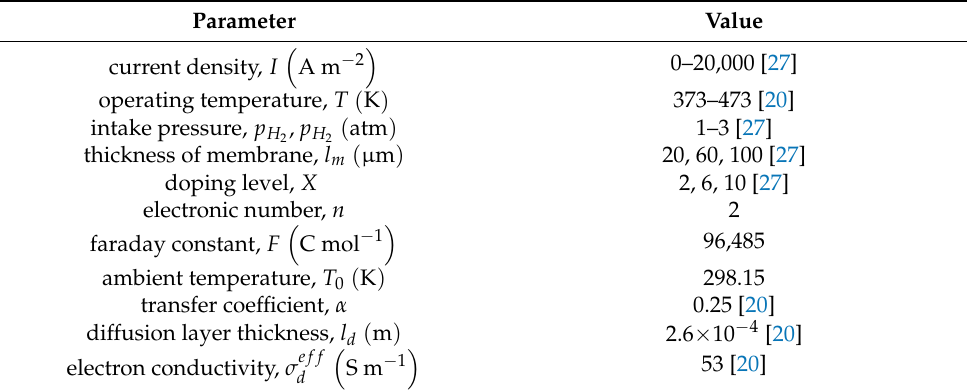
Table 1. Relevant data of